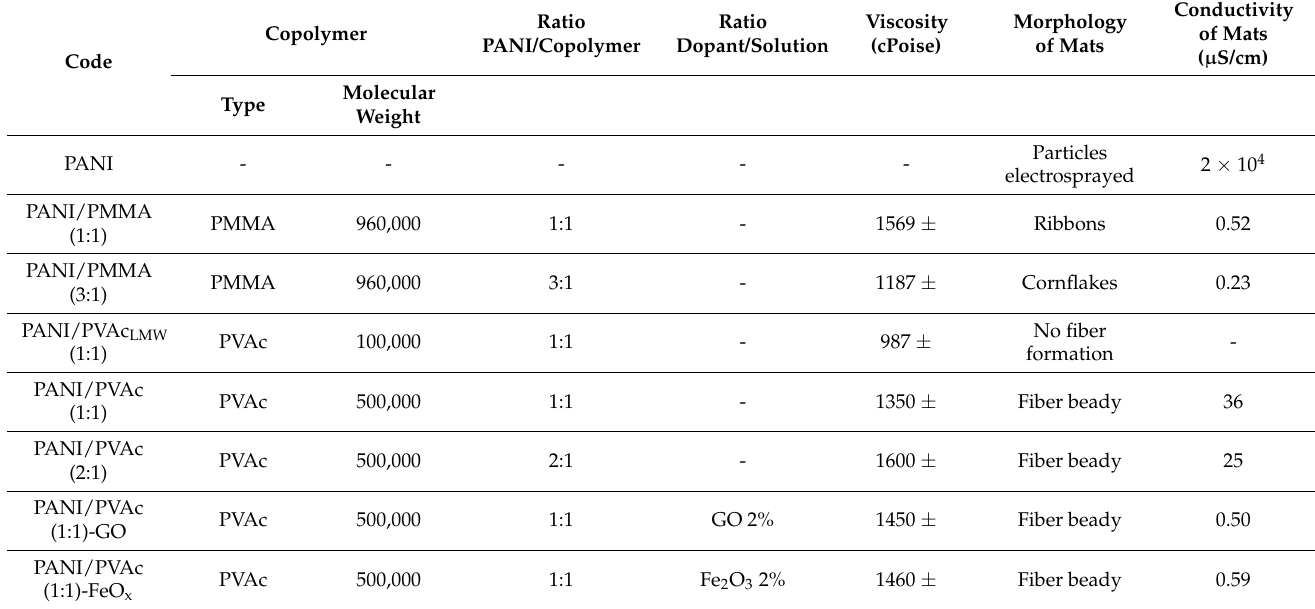
Table 1. List of samples electrospun, viscosities of solution, morphologies of